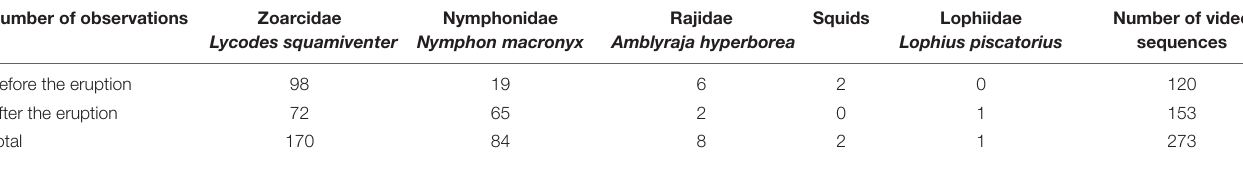
TABLE 2 | Occurrence of the megafaunal taxa observed before and after the mud